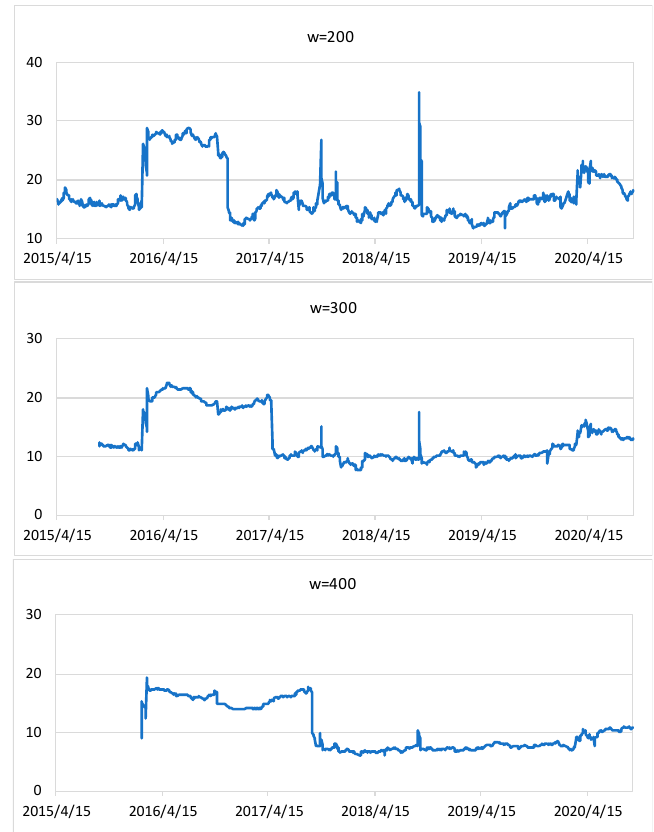
Figure 8. Dynamic total connectedness indexes with window lengths of 200, 300, and 400 observa- tions.